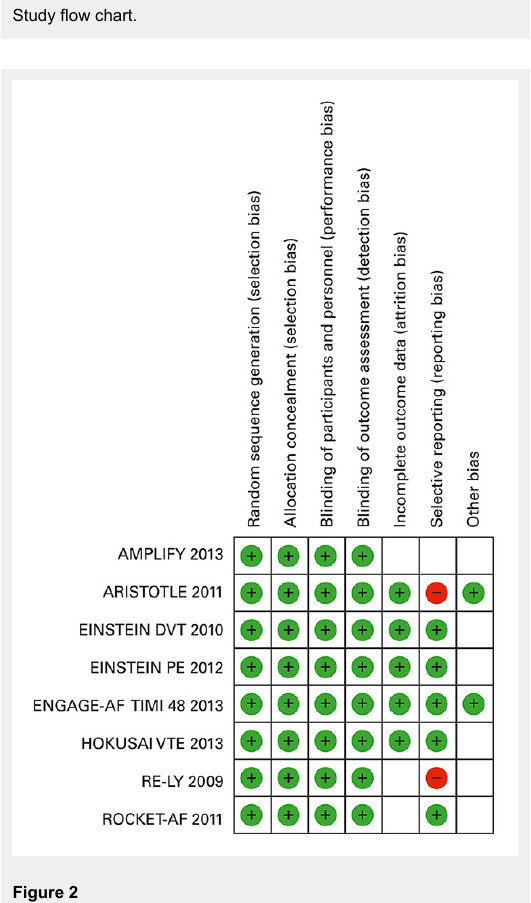
Risk of bias summary. Green: low risk, red: high risk, white: unclear